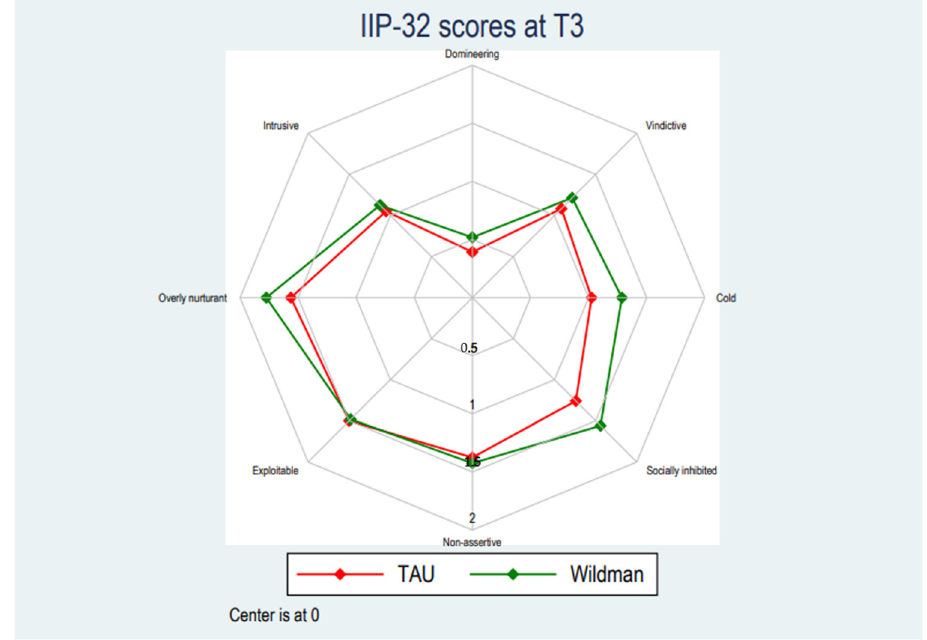
Figure 3. Follow-up score pattern for TAU and the Wildman Programme-group.